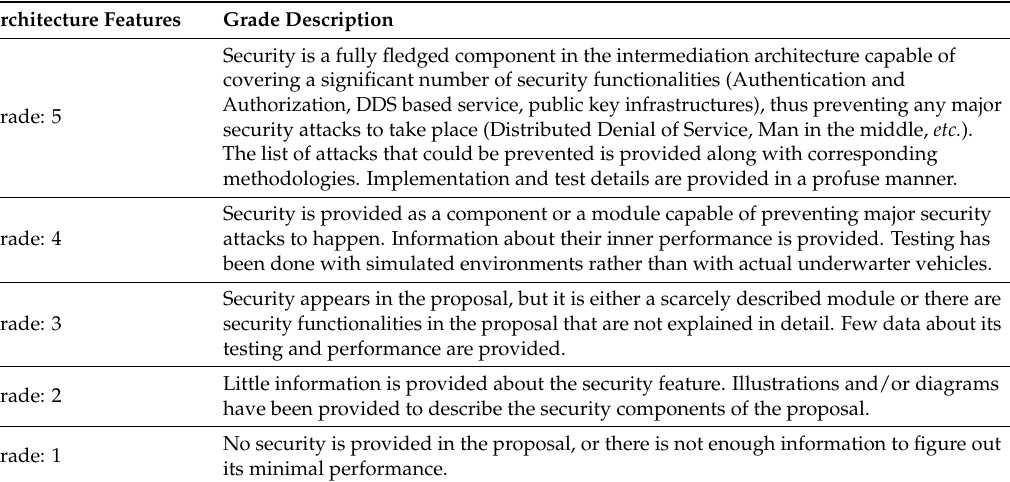
Table 8. Security assessment.